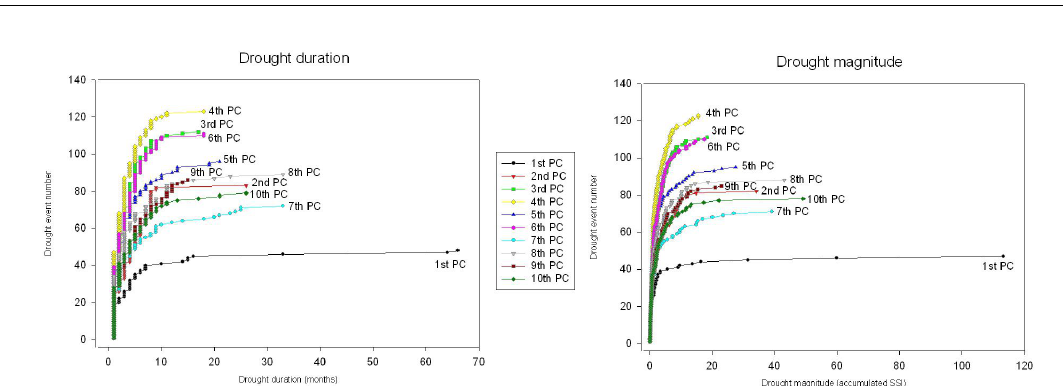
Fig. 6. Left: duration (in months) of the drought episodes (from shortest to longest event). Right: magnitude (in accumulated SSI deficits) of the drought episodes (from minor to major).